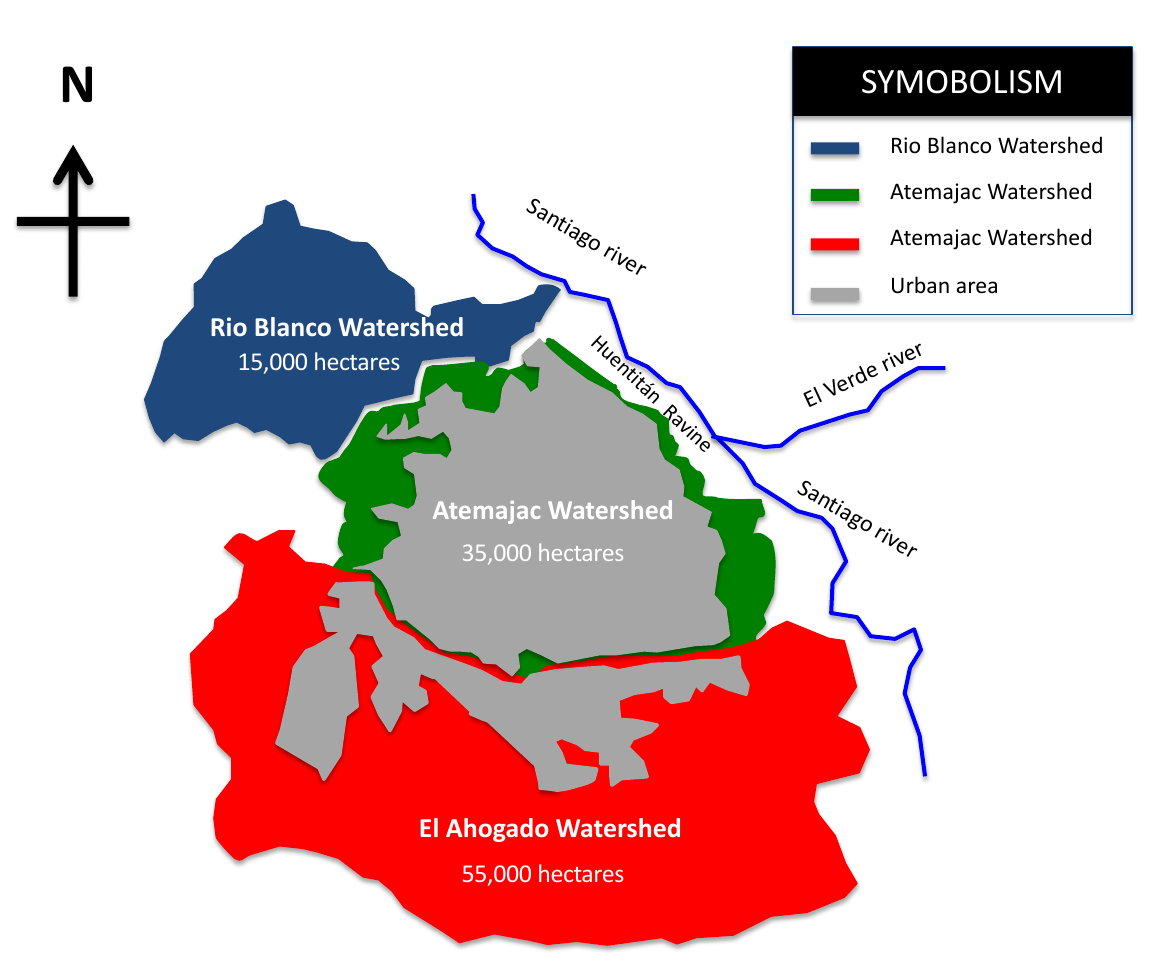
Figure 4. Metropolitan Zone of Guadalajara and its